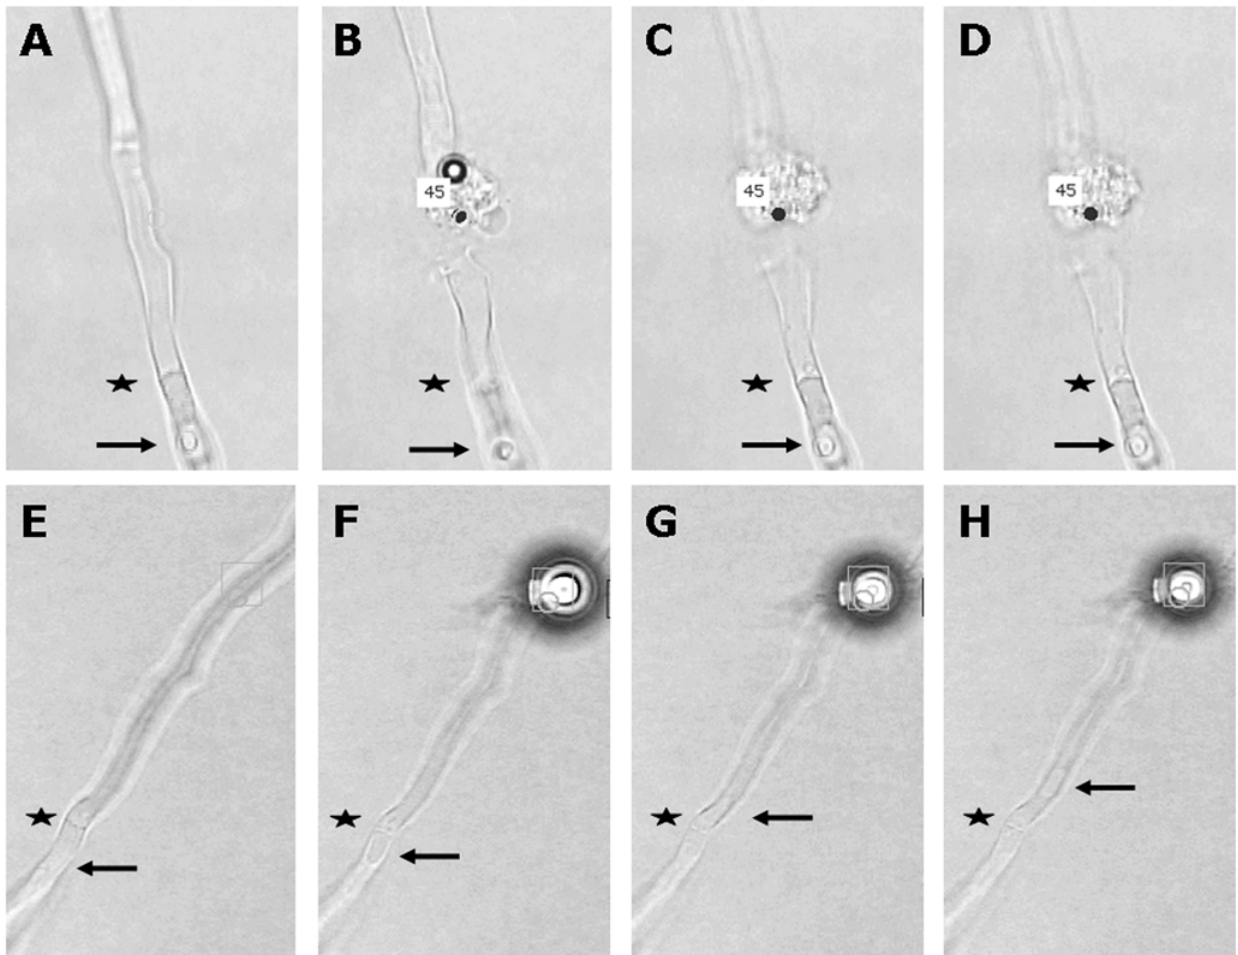
Figure 2. A septum is open when cytoplasm moves through the septum after laser dissection of a neighbouring compartment. Compartments before ( A, E ) and after ( B–D, F–H ) dissection of a hypha with a closed ( A–D ) and an open ( E–H ) septum. Cytoplasmic flow in E–H is indicated by the movement of a vacuole (arrows) through the septum (*). Dots represent the position of the laser.